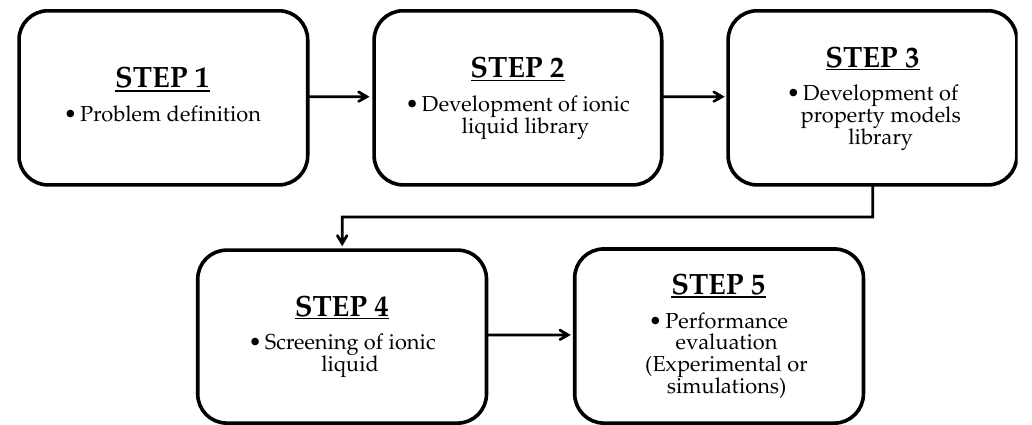
Figure 2. General framework of ionic liquid design via a computer-aided molecular design (CAMD) approach.